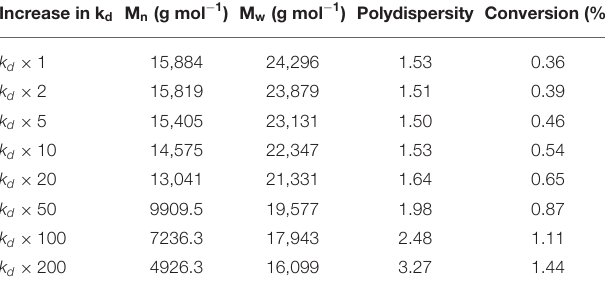
TABLE 1 | Simulation results for the residence time of 5s (influence of increase in k d ).